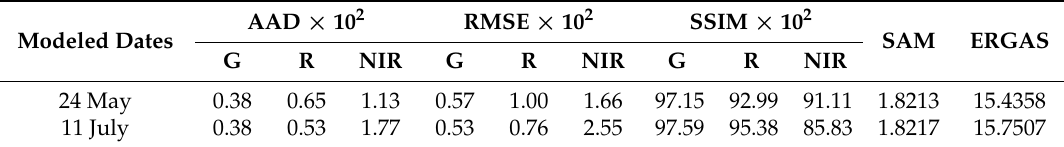
Figure 6. Proposed bi-directional fusion results with temporally extended training samples from the rural dataset: ( a ‒ d ) the composited fusion results modeled on 24 May 2001 and the comparison (green, red, and NIR) with the actual reflectance; ( e ‒ h ) the composited fusion results modeled on 11 July 2001 and the comparison (green, red, and NIR) with the actual reflectance. Table 4. Assessment indices of the proposed bi-directional fusion with temporally extended training samples from the rural dataset.